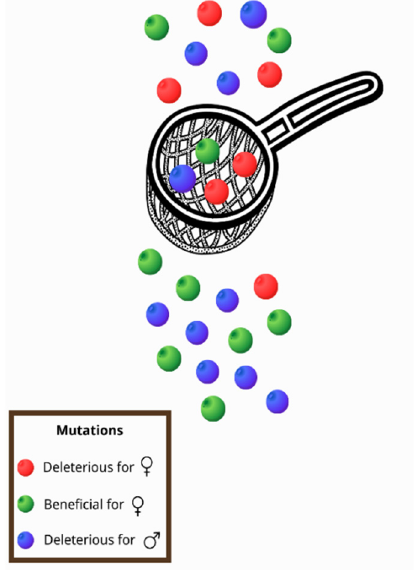
Figure 1. As mitochondria are inherited only by females, a sex-specific selective sieve is created. Thus, mutations that are beneficial for women (green) pass through the sieve, but mutations that reduce female fitness (red) are usually removed. However, in this way, mutations that are deleterious for males (blue) are usually transferred to offspring as they are not subject to selection through females.